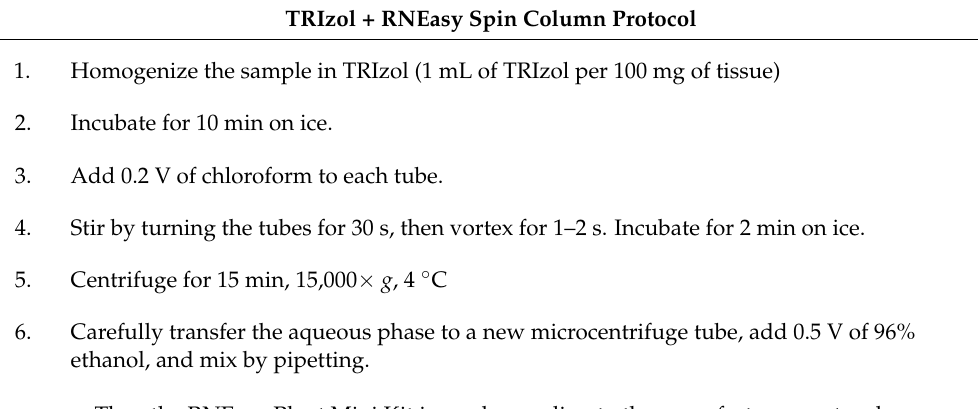
Table 2. Combined TRIzol and spin column RNA isolation